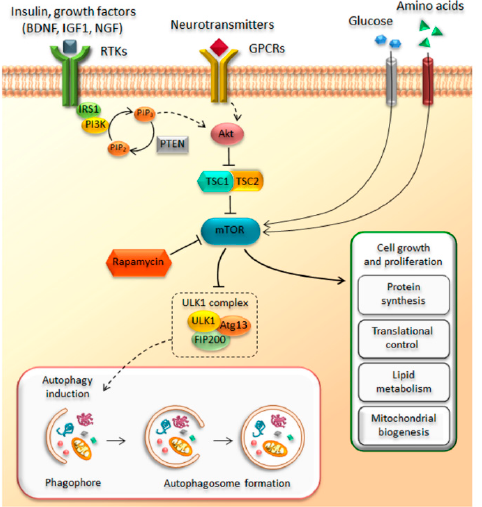
Figure 1. The mammalian target of rapamycin (mTOR) pathway. The cartoon summarizes the main up- and down-stream components of the mTOR pathway. Growth factors, glucose, and amino acids activate mTOR, which in turn promotes protein synthesis, lipid metabolism, and mitochondrial biogenesis, while